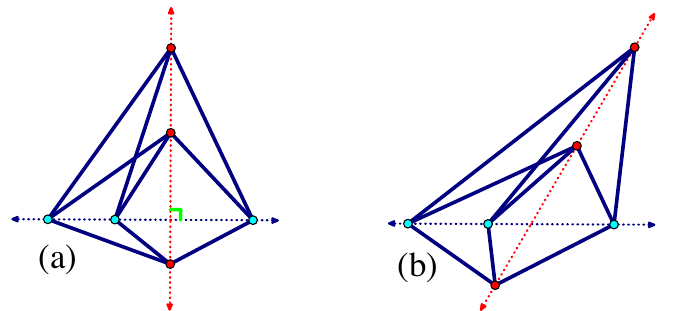
Figure 74. K 3.3 on two lines is dependent, with an infinitesimal motion. When the lines are per- pendicular ( a ) this extends to a finite motion. After an affine transformation ( b ) the motion does not